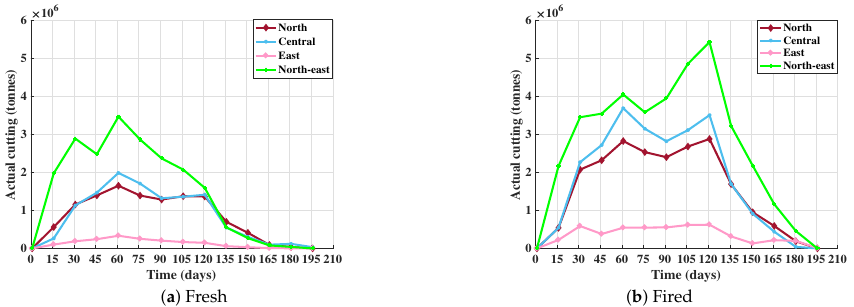
Figure 3. Actual cutting patterns for fresh and fired sugarcane for 2017/18.